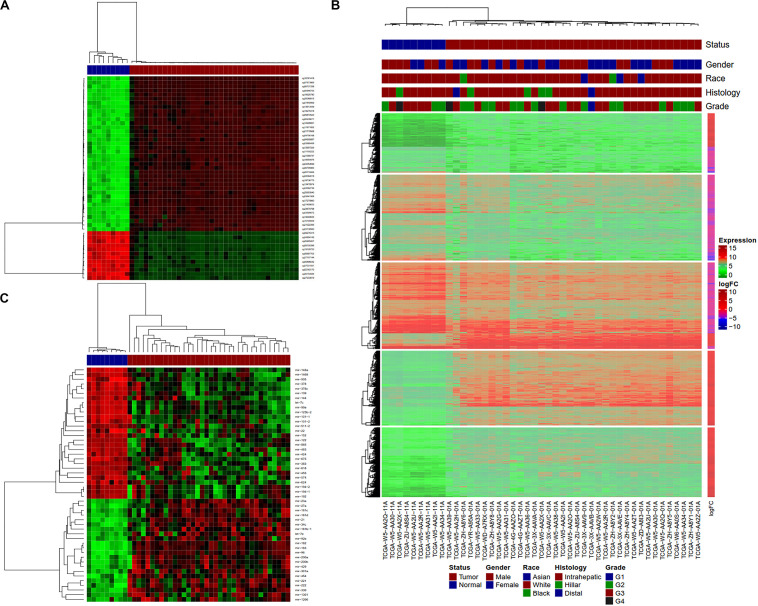
Clustering analysis of normal and tumor CCA samples using Dm-CpGs and DEGs. (A) Heatmap plot based on the top 50 differentially methylated CpG sites. (B) The vertical sidebar shows expression fold change in tumor Upper horizontal bars represent sample annotations of on disease status, gender, race, histology and tumor grade. (C) Heatmap plot based on the top 50 differentially expressed miRNAs.